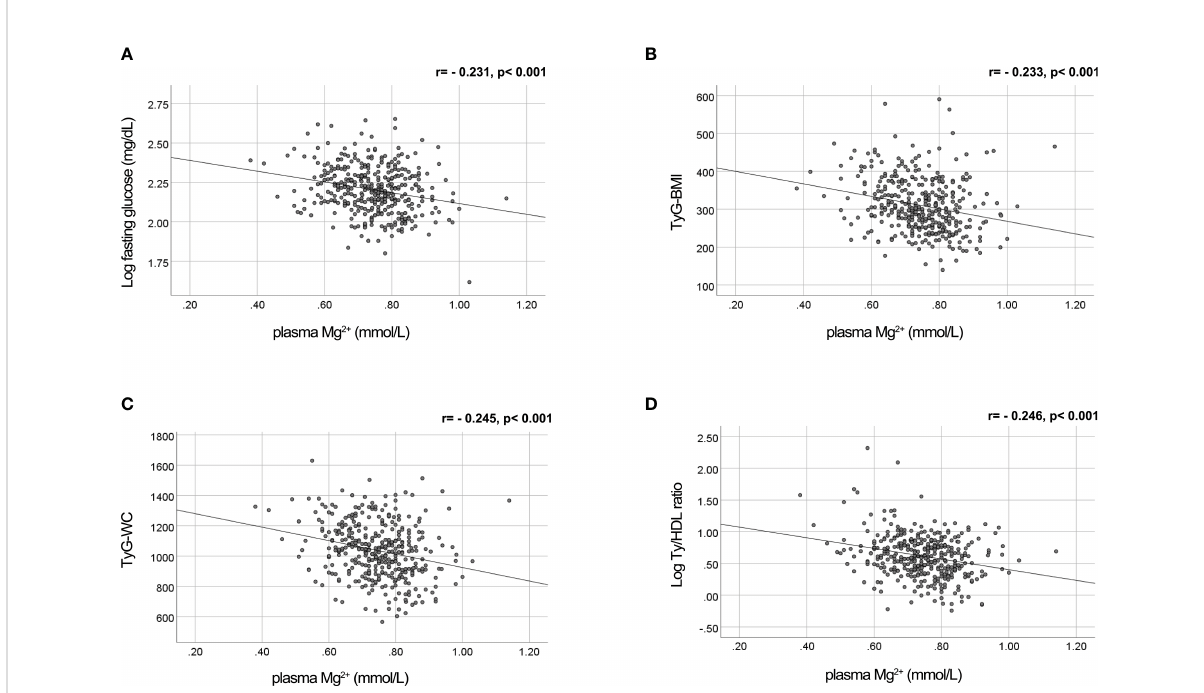
FIGURE 1 Mg 2+ is negatively correlated with fasting glucose levels and insulin resistance markers TyG-WC, TyG-BMI and Ty/HDL ratio in people with T2D. Plasma Mg 2+ concentration scatter plotted versus (A) Log fasting glucose (n=382); (B) TyG-BMI (n=379); (C) TyG-WC (n=376); and (D) Log Ty/ HDL ratio (n=384) in people with T2D. Statistically analyzed using Pearson correlation. Mg 2+ , magnesium; T2D, type 2 diabetes; TyG-BMI, Triglyceride Glucose-Body Mass Index; TyG-WC, Triglyceride Glucose-Waist Circumference; Ty/HDL, Triglyceride High Density